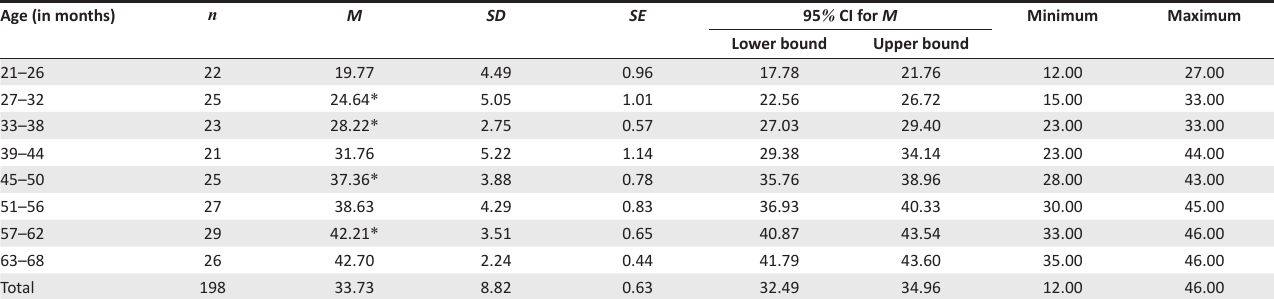
TABLE 7: Receptive language Mullen Scales of Early Learning raw scores, standard deviations, confidence intervals and the range of scores for each age group. Age (in months)